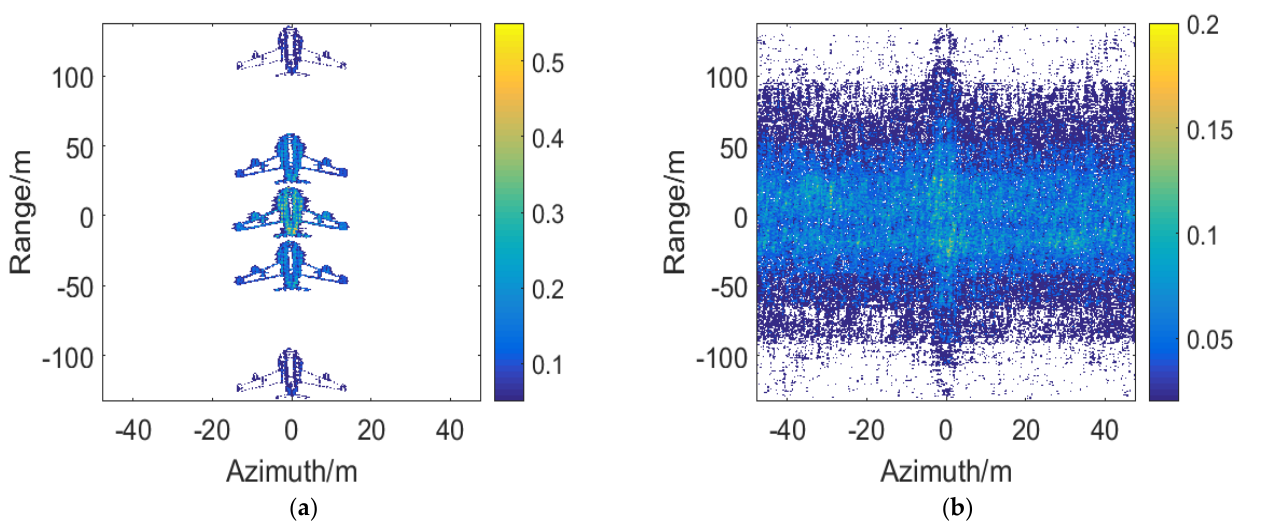
Figure 6. The modulated ISAR results. ( a ) AFSS periodic modulation. ( b ) Two-dimensional AFSS modulation.